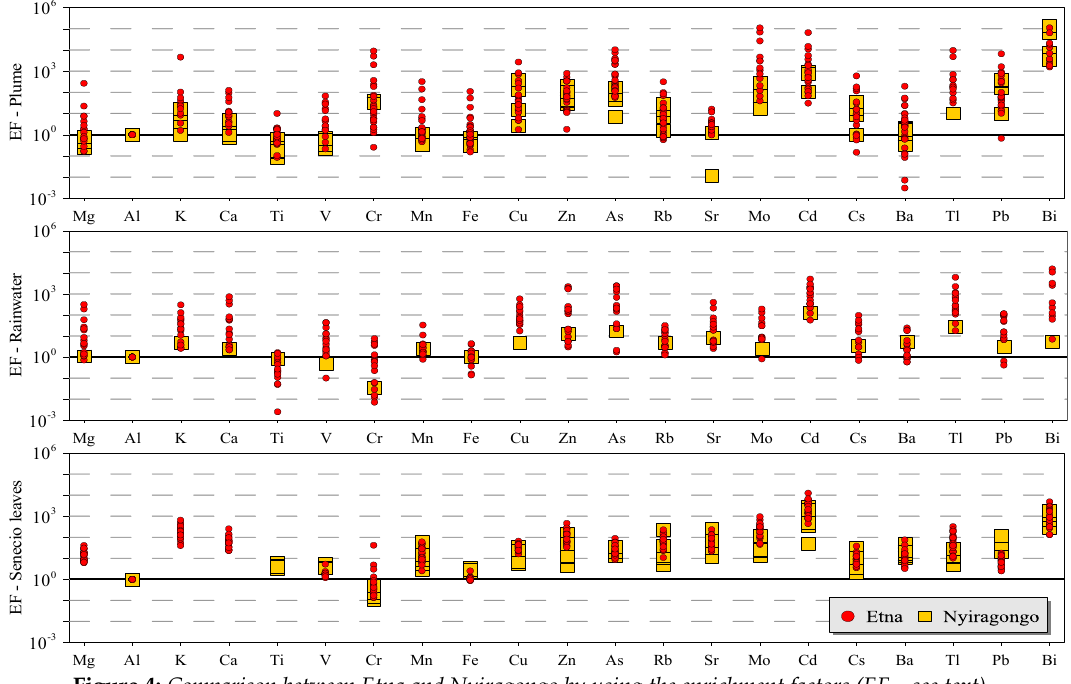
Figure 4: Comparison between Etna and Nyiragongo by using the enrichment factors (EF – see text). R